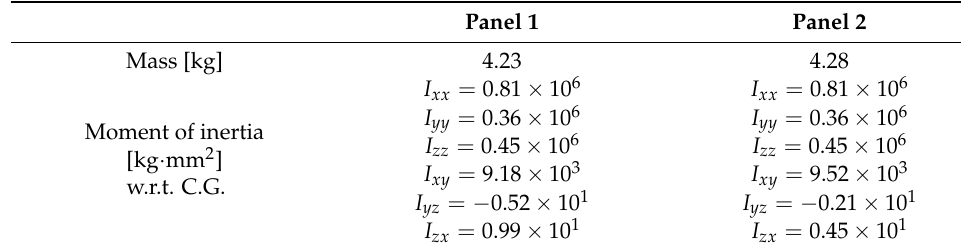
Table 7. Dimensions and mass properties of inner and outer panels.